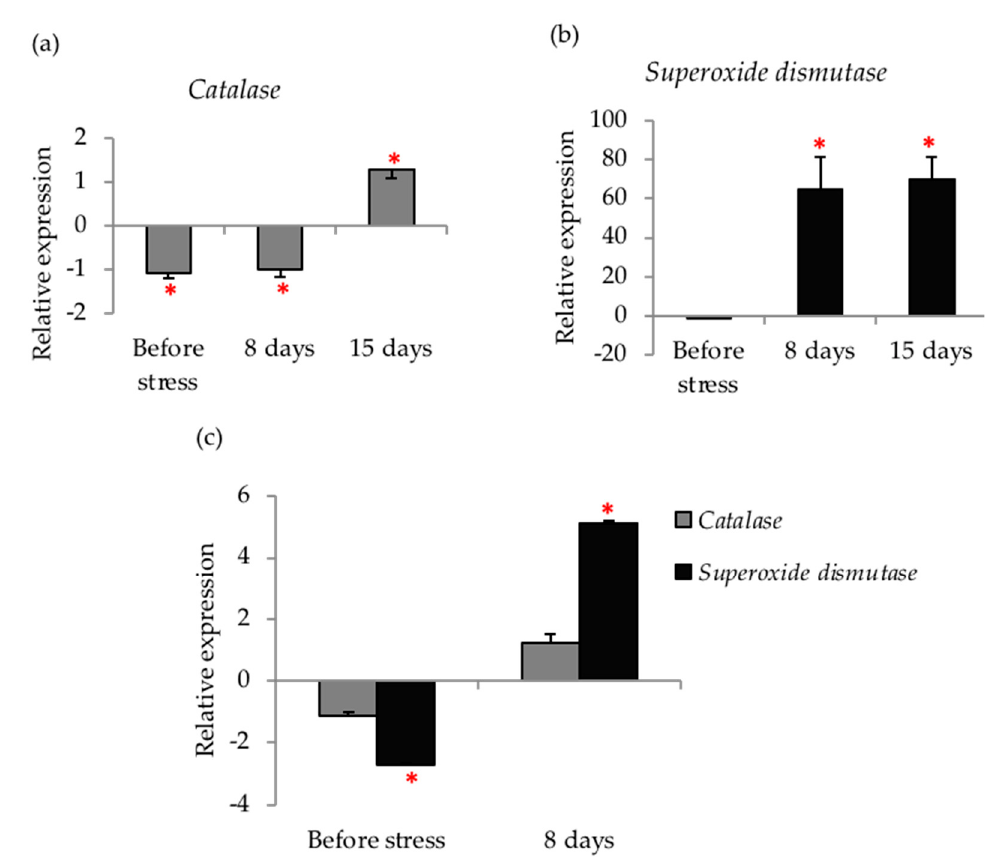
Figure 5. Transcriptional responses of ROS detoxification enzymes, catalase, and superoxide dismutase, in a representative transgenic line, each ectopically overexpressing HvFC1 ( a , b ) or HvFC2 ( c ) under drought stress, relative to WT control. The data are shown as mean ± standard error (SE) of 3 different plants. Asterisks indicate statistically significant expression difference between transgenics and WT control, at * p < 0.05, based on two-way ANOVA.